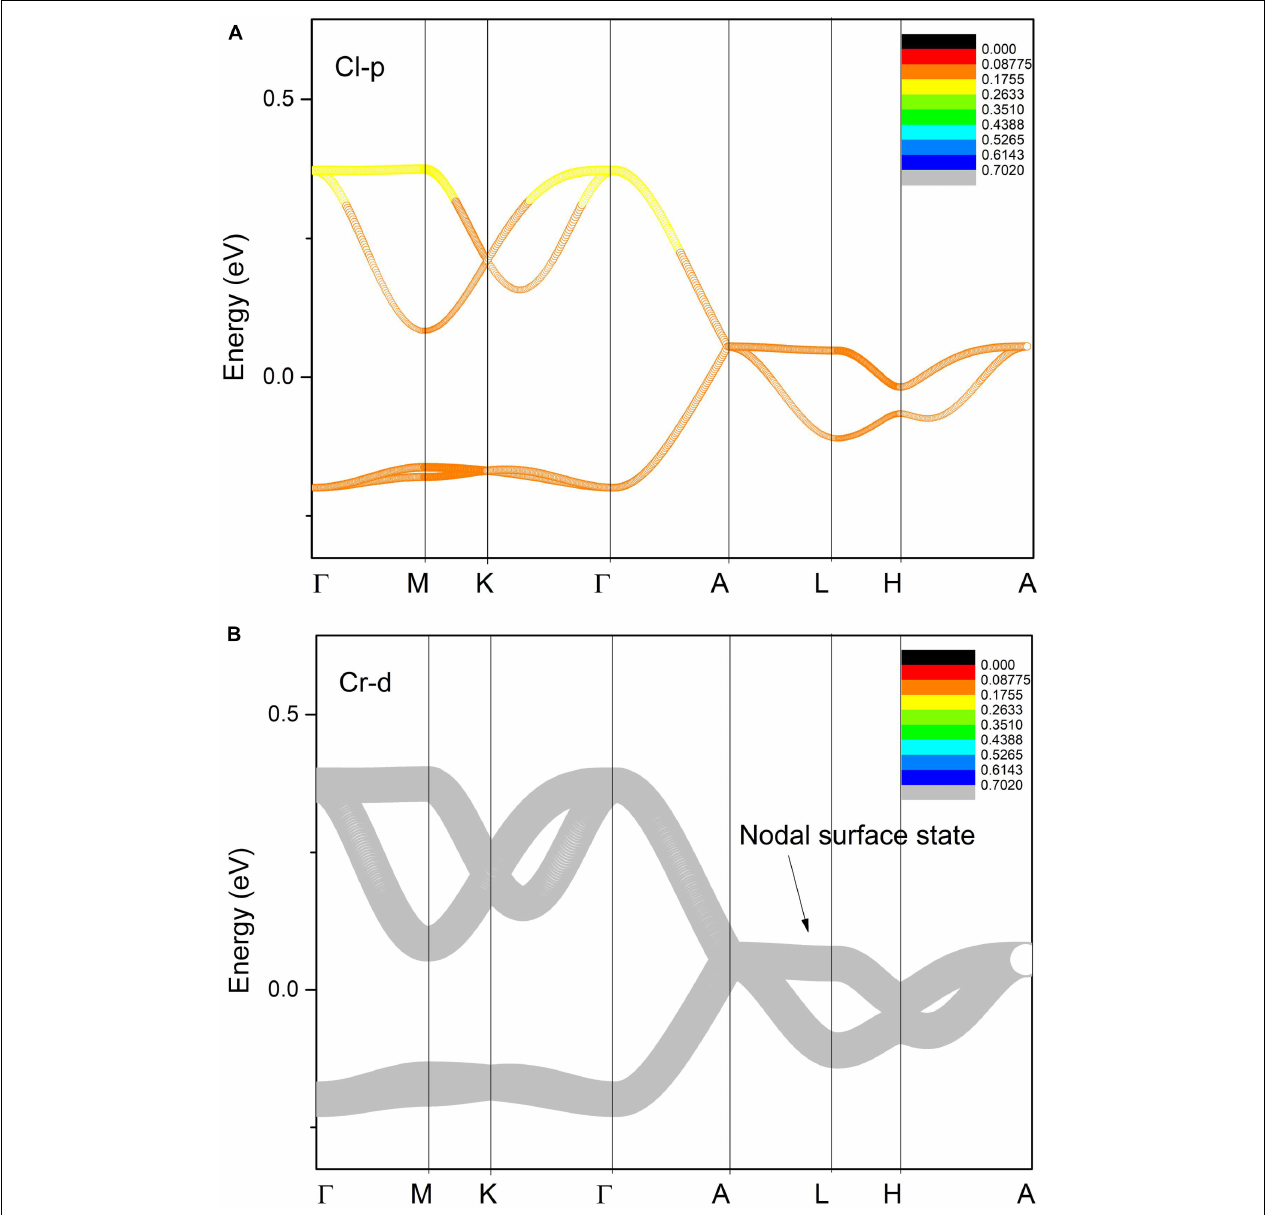
FIGURE 8 | Orbital-resolved band structures of Cl- p (A) and Cr- d (B) orbitals of CsCrCl 3 in the spin-up channel. The nodal surface state, formed by the crossing of two bands near the E F , is highlighted by an arrow along the A-L-H-A direction.